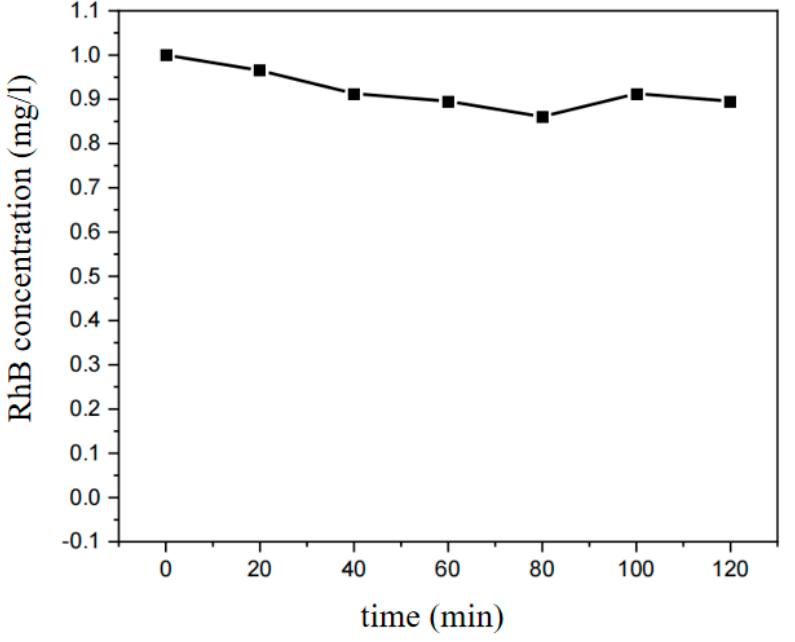
Figure 3. Adsorption experiment of MIL-53(Fe)@CF photocatalytic membrane to RhB under no light irradiation (pH at 4.5, MIL-53(Fe)@CF photocatalytic membrane at 150 mg, RhB 1 mg/L). 3.3. Effects of Catalysts, Light Irradiation, and Electron Trapping Agents on Photocatalytic Degradation of